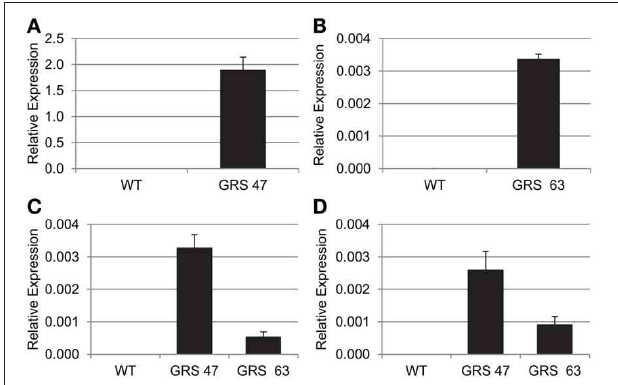
FIGURE 2 | Transgene transcript abundance as determined by RT-qPCR, relative to EF1a expression. (A) CmGAS1 expression in WT and GRS47 (note the Y-axis scale). (B) CmGAS1 expression in WT and GRS63. (C) CsRFS expression in WT, GRS47 and GRS63. (D) AmSTS expression in WT, GRS47 and GRS63. Variation is expressed as SD; n = 4 sibling plants.